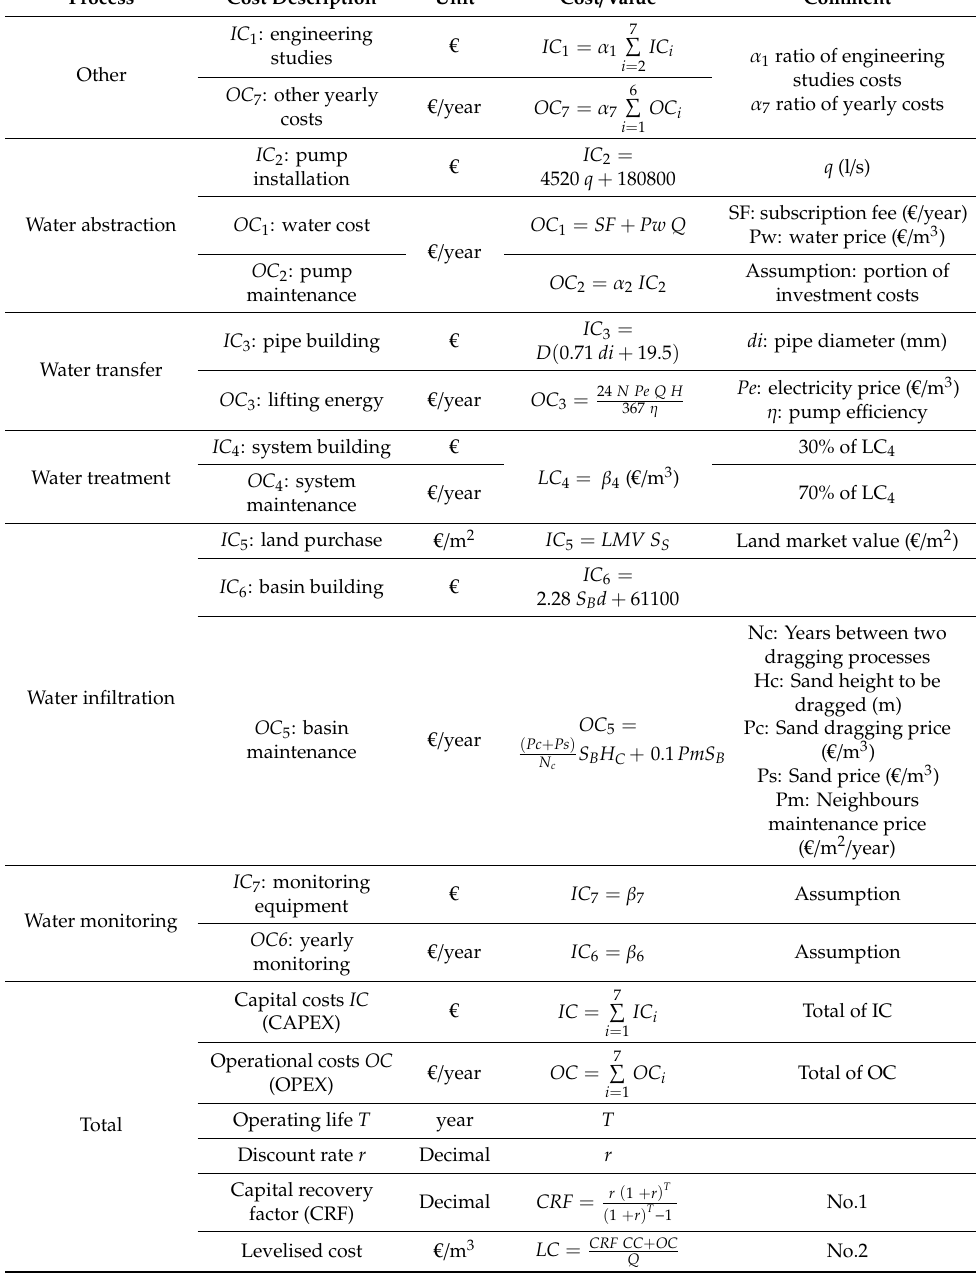
Table 2. Summary of costs for a MAR scheme (recharge through infiltration basin option). α and β are fractional parameters in order to define specific costs as a fraction of other